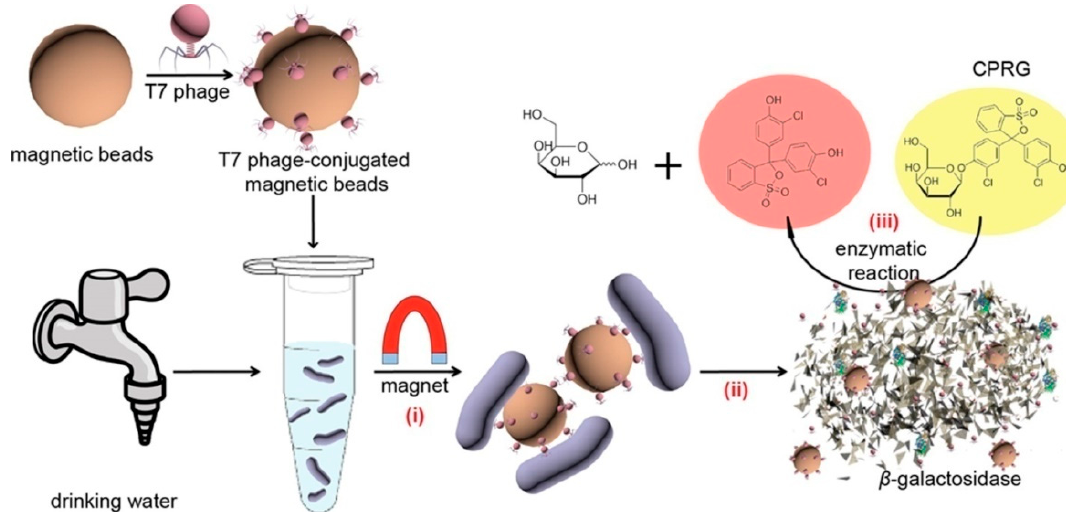
Figure 10. Schematic representation of the use of T7 bacteriophage-conjugated magnetic probe to detect Escherichia coli in drinking water ( i ) Introduction of T7 bacteriophage-conjugated magnetic probe to attack E. coli and separate it by the influence of magnet ( ii ) The explosion or lysis of E. coli and the release of T7 phages and β -gal; ( iii ) β -gal catalyzed CPRG hydrolysis to produce colorimetric signal (adapted with permission from [26]. Copyright (2015) American Chemical Society).